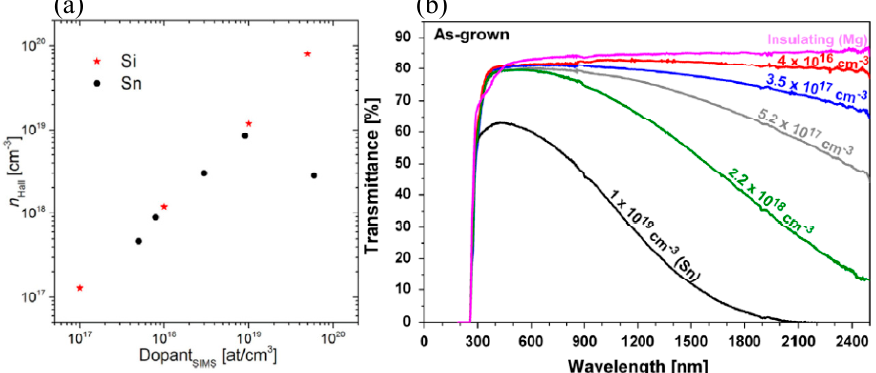
Figure 3. ( a ) Hall free carrier concentration versus the dopant (Si and Sn) concentration obtained